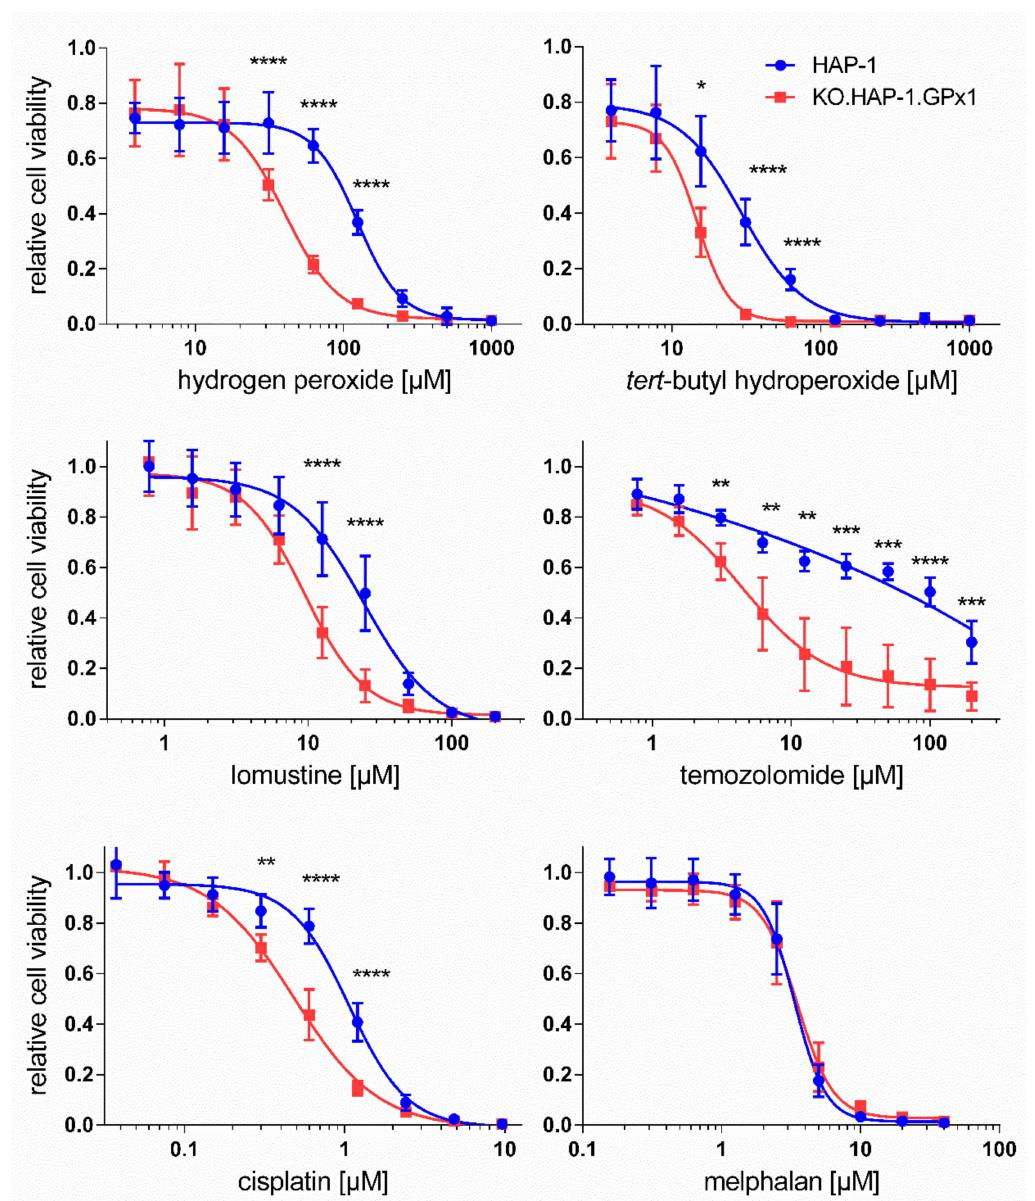
Figure 2. Dose-response curves for the inhibition of cell viability by peroxides and several anticancer drugs in HAP-1 (blue) and KO.HAP-1.GPx1 cell line (red) after 48 h incubation time, as determined by the), 3-(4,5-dimethylthiazol-2-yl)-2,5-diphenyltetrazolium bromide (MTT) assay. All results show mean ± standard deviation of at least four independent experiments. Significance tested by unpaired, two-sided t -test: * p < 0.05, ** p < 0.01, *** p < 0.001, **** p <